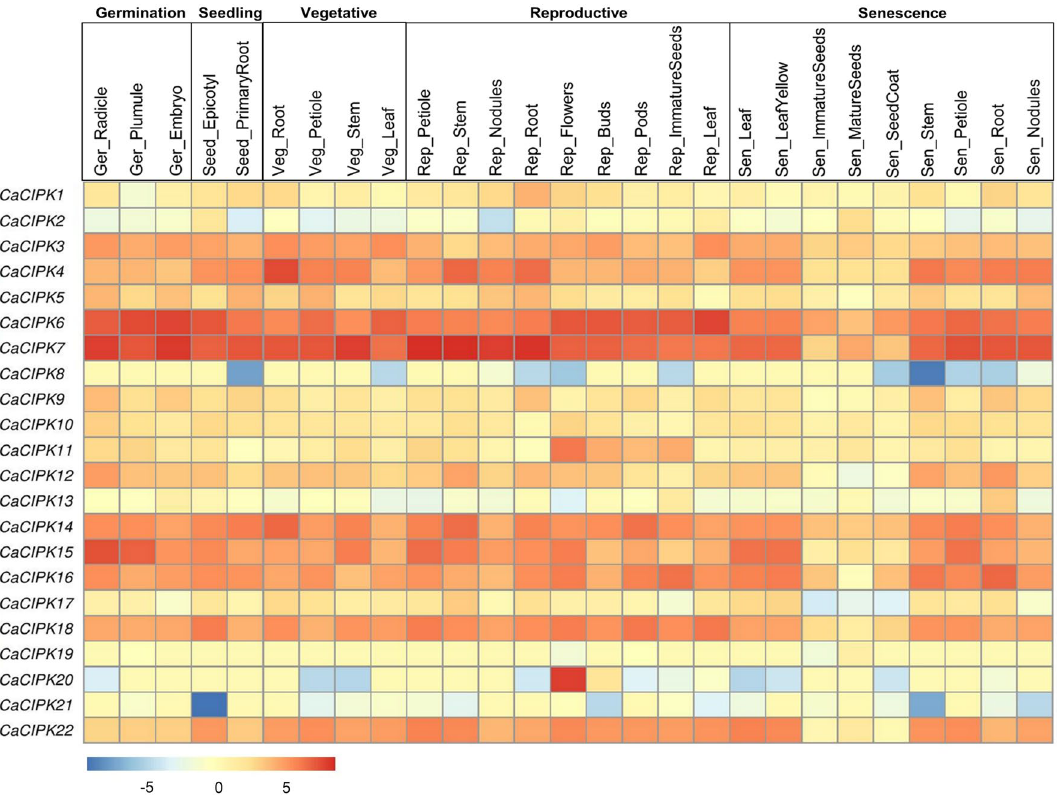
Figure 8. Expression profiles of different CIPK genes in different developmental stages of chickpea. The heatmap represents the expression pattern of CaCIPK genes in the developmental stages of different tissues such as germination, seedling, vegetative, reproduction and senescence. The genes are named on the left and different tissues/developmental stages are labelled at the top. Scale bar represents the normalised log_2 FPKM